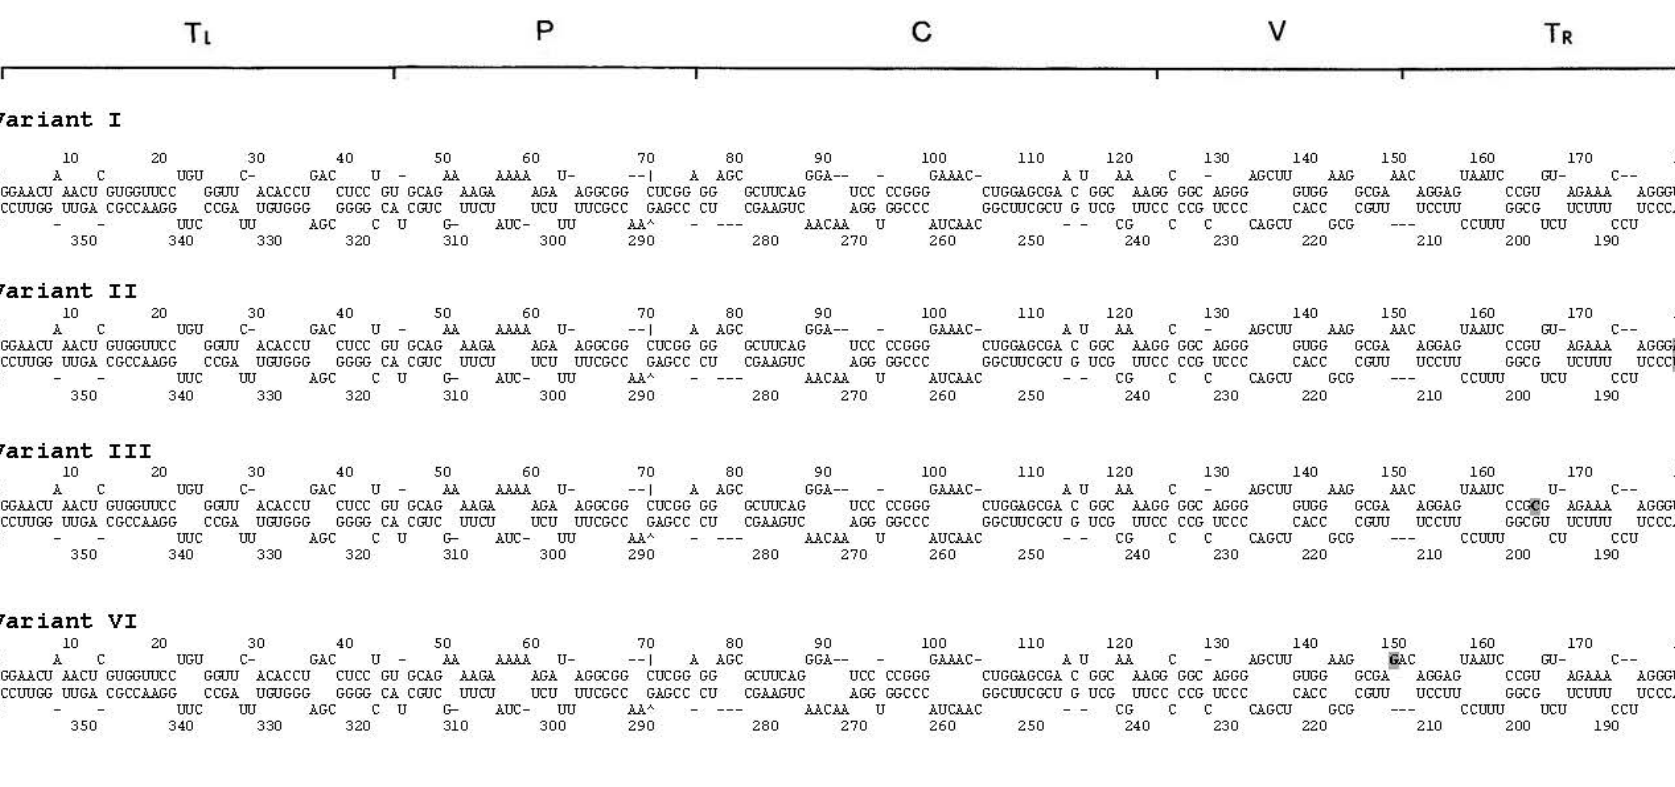
Figure 2. Secondary structure of Tomato chlorotic dwarf viroid (TCDVd) and Potato spindle tuber viroid (PSTVd) sequence variants. : left terminal region, P: pathogenic region, C: central conserved region, V: variable region, ( A ) TCDVd; ( B ) PSTVd variants I to VIII. T L : right terminal region. The shaded nucleotides are nucleotides that were different from variant I, which is identical to the TCDVd sequence T R AF162131 (A) or the PSTVd sequence EF044303